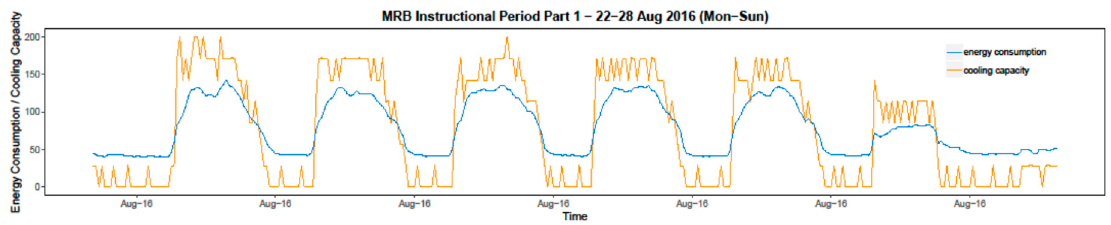
Figure 2. Weekly cycles in the data.